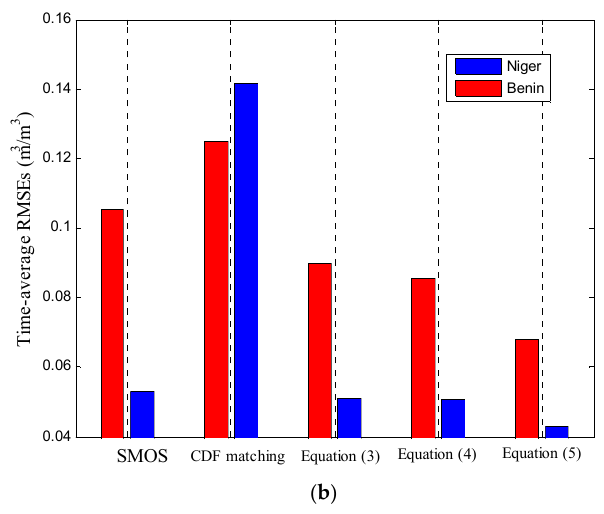
Figure 2. ( a ) Rescaling functions (polynomial fit) of retrieval ensembles; ( b ) time-average RMSEs (m 3 /m 3 ) of the original SMOS data, CDF matching, Equations (3)–(5).